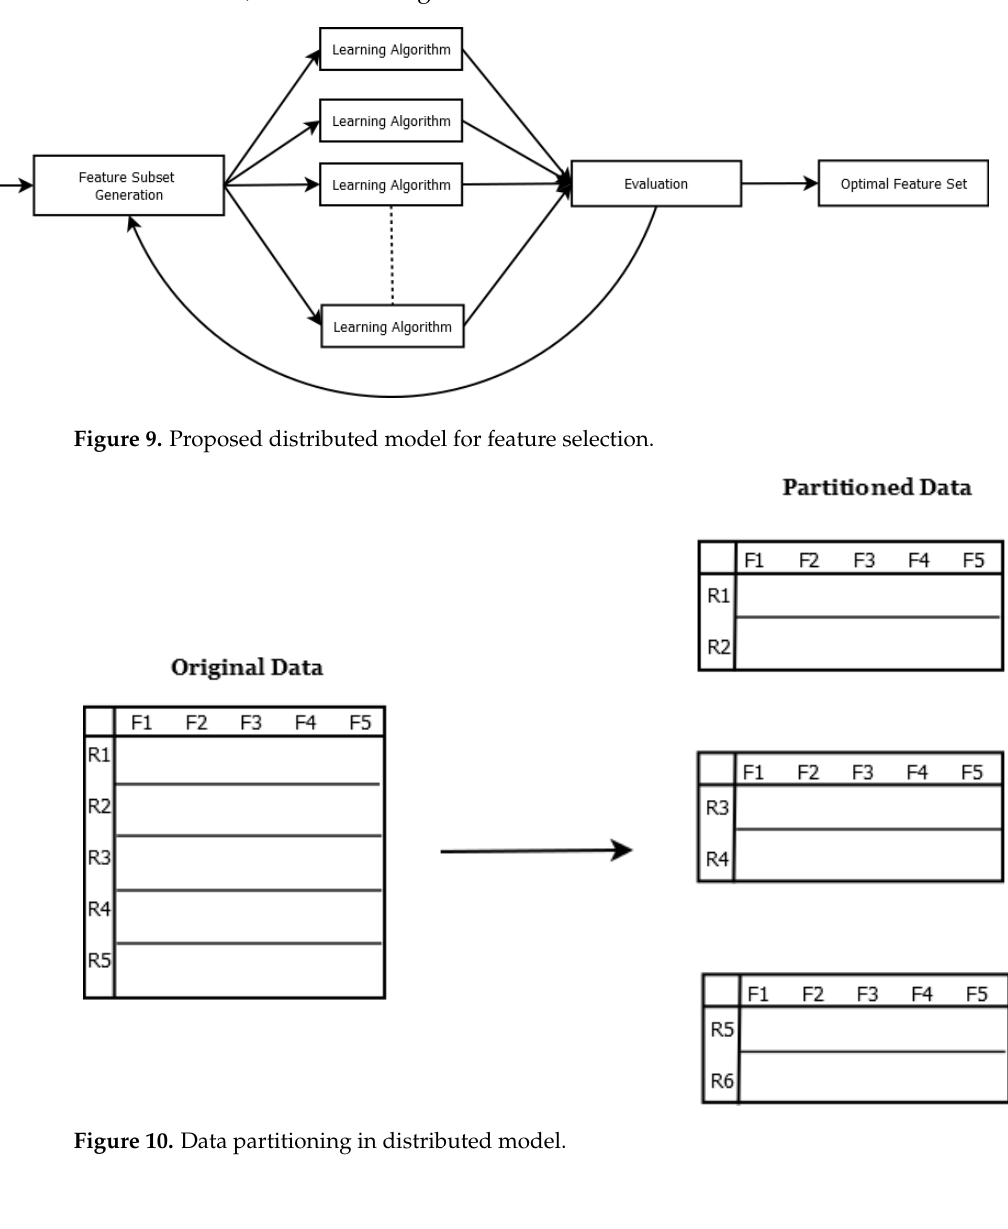
Figure 10. Data partitioning in distributed model. The performance of the proposed model was compared with existing distributed fea ‐ ture selection models, namely VectorSlicer, RFormula, ChiSqSelectotr, UnivariateFeature Selector, and VarianceThreshold Selector. Table 2 demonstrates that, across the majority of datasets, the minimum number of features was acquired by using the proposed distrib ‐ uted FCM ‐ based feature selection technique. The datasets for which the proposed algo ‐ rithm selected the smallest number of features has been highlighted. For all but three da ‐ tasets, the proposed model chose the smallest number of features. The effectiveness of the optimum feature set acquired using FCM ‐ based feature selection was evaluated using five classification algorithms: Naïve Bayes, Decision Tree, Random Forest, Multilayer Percep ‐ tron, and Multinomial Logistic Regression. After FCM ‐ based feature selection, the da ‐ tasets used for evaluation yielded accuracy values which are displayed in Table 3. The findings indicate that, compared to other classification methods, the Random Forest ap ‐ proach often yielded the highest accuracy scores for the considered datasets. The Random Forest method employs a majority agreement prediction technique, wherein a group of individual decision trees form an ensemble, thereby reducing the number of possible types of error and leading to higher accuracy of results. Hence, using the Random Forest algorithm, the performance of the proposed model was compared with existing feature